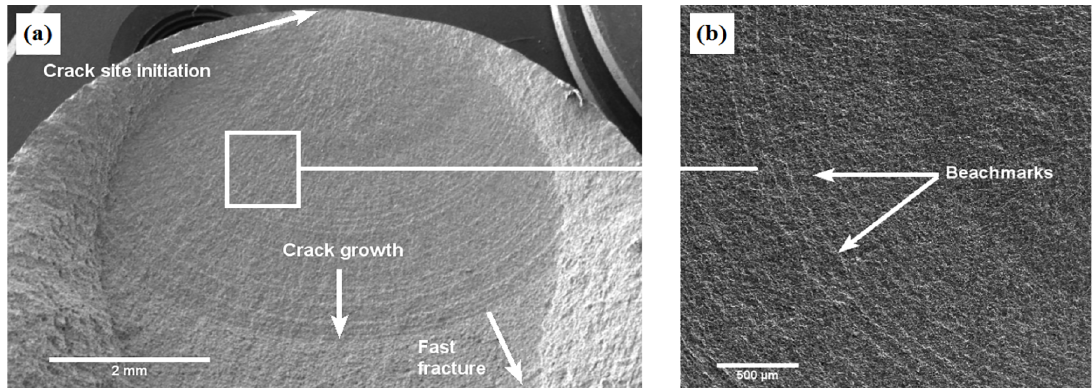
Figure 9 . Annealed Inconel 625 fracture surface showing stable crack growth region by fatigue (on the left); and an enlargement of the white square region (to the right).